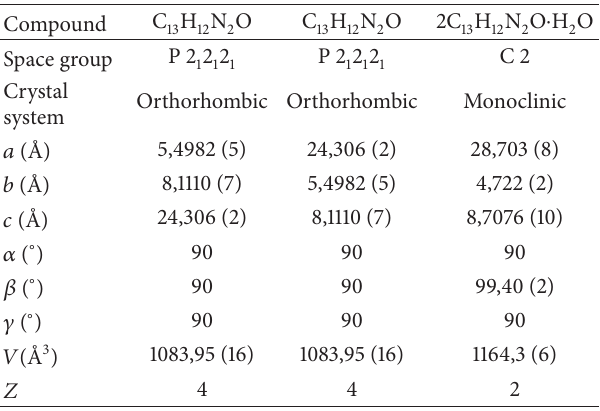
Table 3: The crystallographic parameters of C 2C